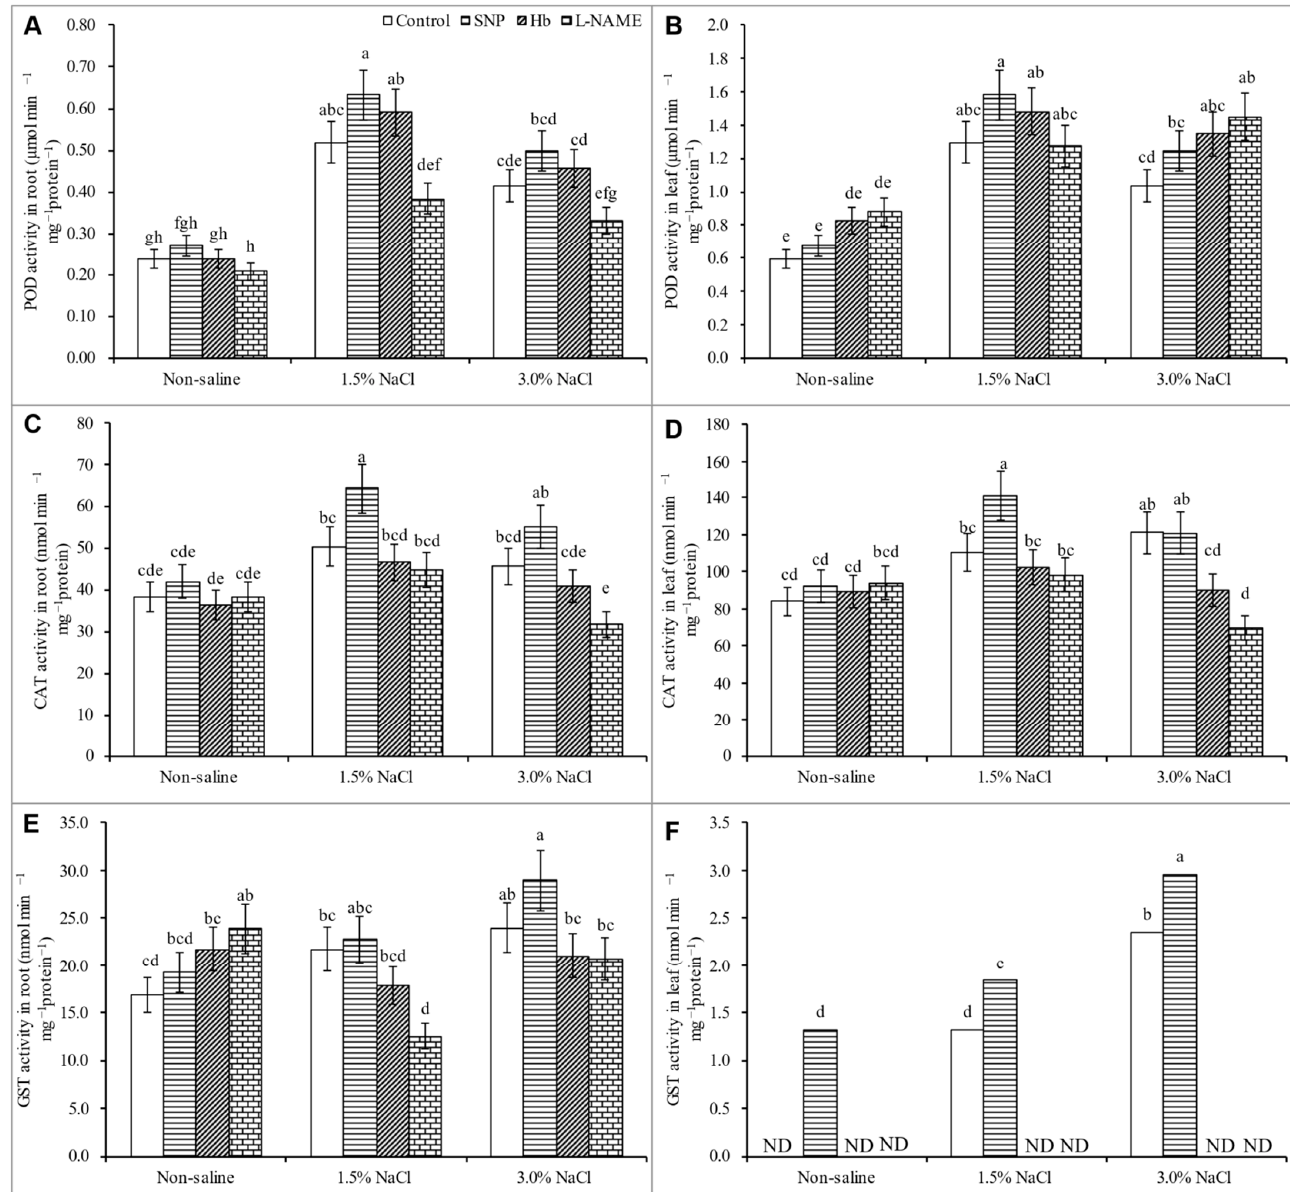
Figure 8. Activity of POD ( A , B ), CAT ( C , D ) and GST ( E , F ) in roots and leaves of Kandelia obovata treated with different salt concentrations and with 100 µM sodium nitroprusside (SNP, a NO donor), hemoglobin (Hb, a NO scavenger), or N ω -nitro- L -arginine methyl ester ( L -NAME, a NO synthase inhibitor). Mean (± SD) was calculated from three replicates for each treatment. Bars with different letters are significantly different at p ≤ 0.05, applying Tukey’s HSD test.